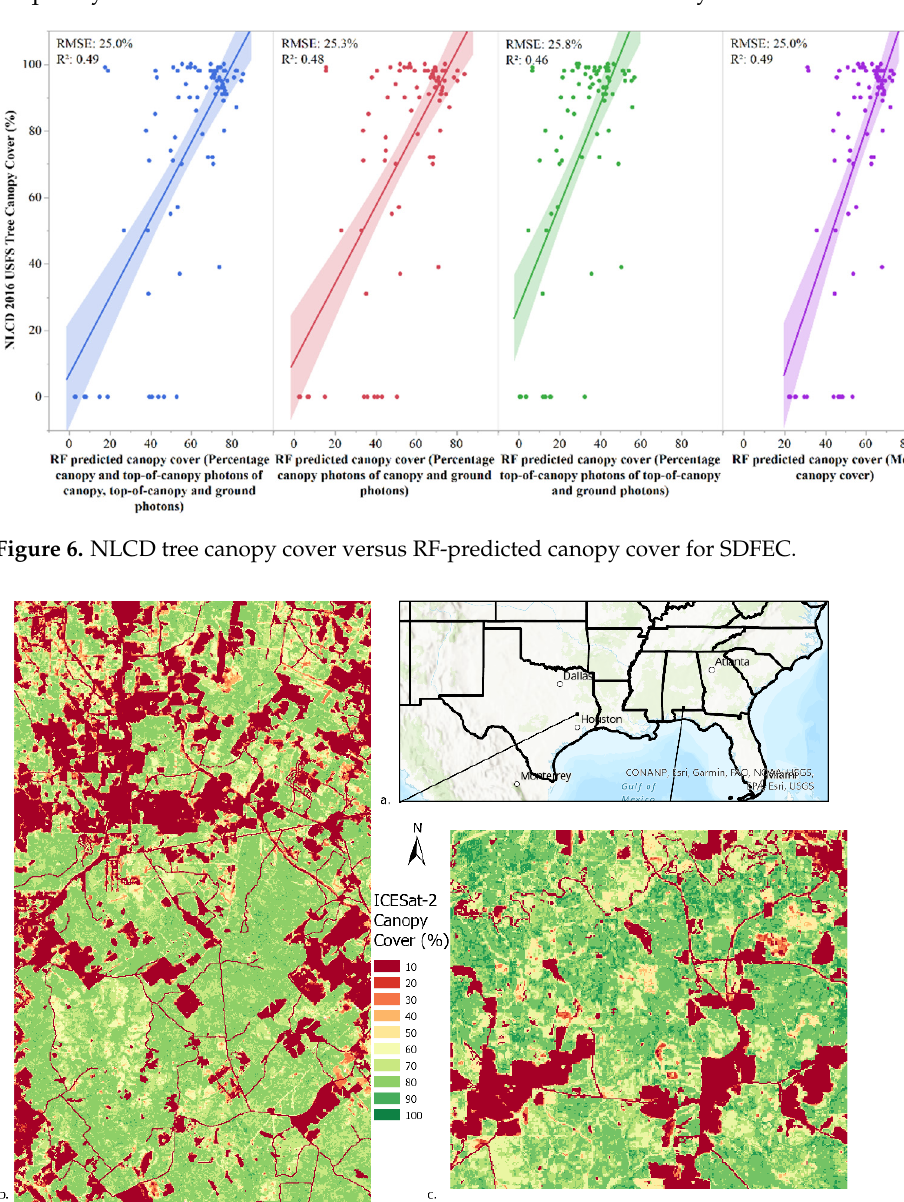
Figure 6. NLCD tree canopy cover versus RF-predicted canopy cover for SDFEC.